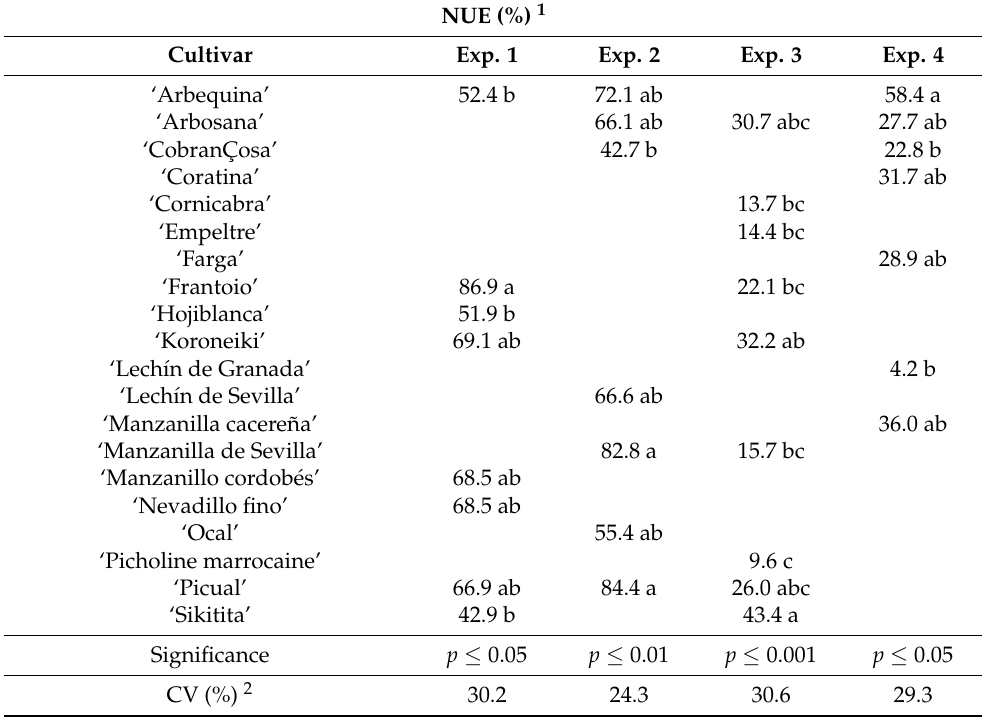
Table 3. Nitrogen uptake efficiency of 20 olive cultivars.